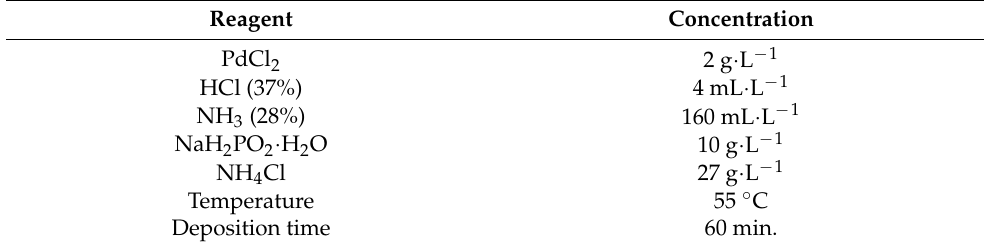
Table 2. Palladium chemical plating bath composition and